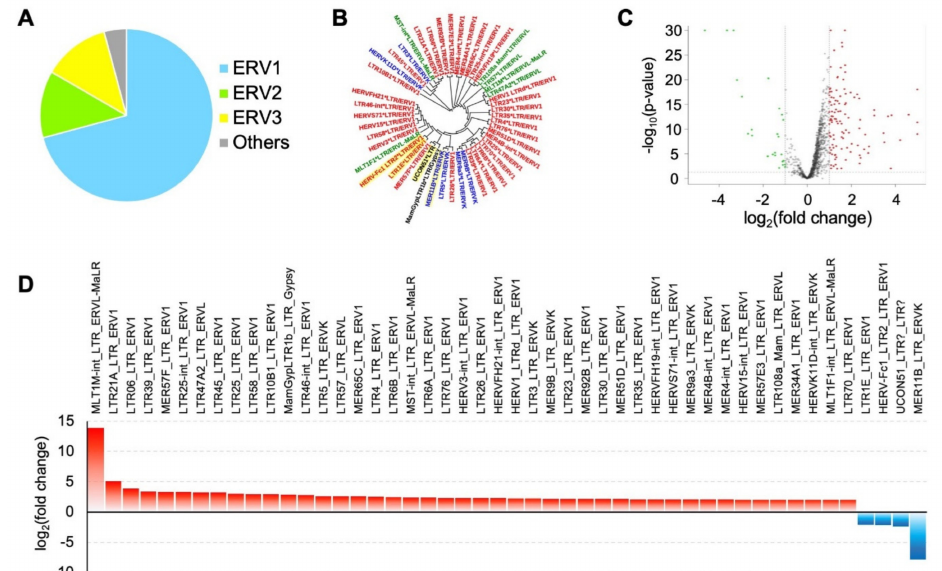
Figure 2. Differential expression of repetitive elements in GBM and normal brain samples. ( A ) The major categories (ERV1, ERV2, ERV3, and others) of LTR elements differentially regulated in GBM and normal brain samples. ( B ) Phylogenetic analysis of the LTR elements differentially expressed in GBM. The phylogenetic tree was constructed by the maximum likelihood method with GTR + I + G and with a bootstrap value of 1000. Red: ERV1; blue: ERVK; green: ERVL; black: others. ( C ) The volcano plot for differentially expressed repetitive elements in GBM. The x-axis shows the fold change in the expression level of repetitive elements in GBM. The y-axis represents the significance ( p -value). The significant ( p -value < 0.05 and |fold change| ≥ 2) up (red) and down (green) elements as well as insignificant elements (black) are plotted. ( D ) The bar chart for LTR elements differentially expressed in GBM. The y-axis represents the fold change of upregulated (red) and downregulated (blue) elements in